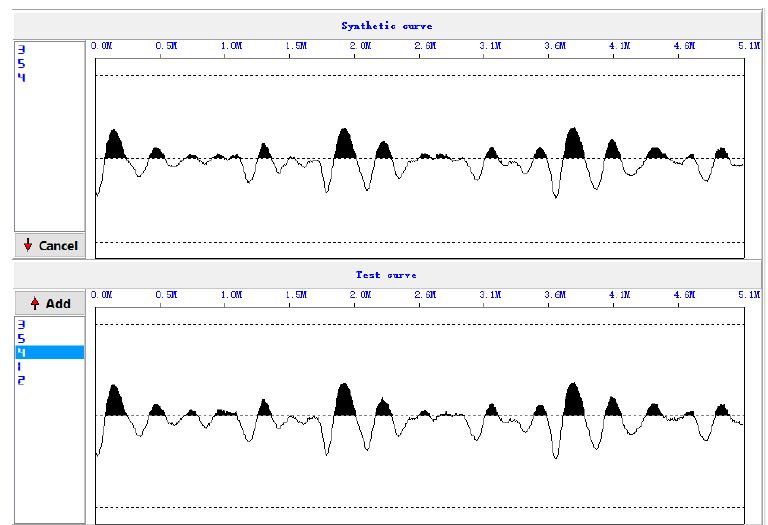
Figure 7. Superimposed waveforms.